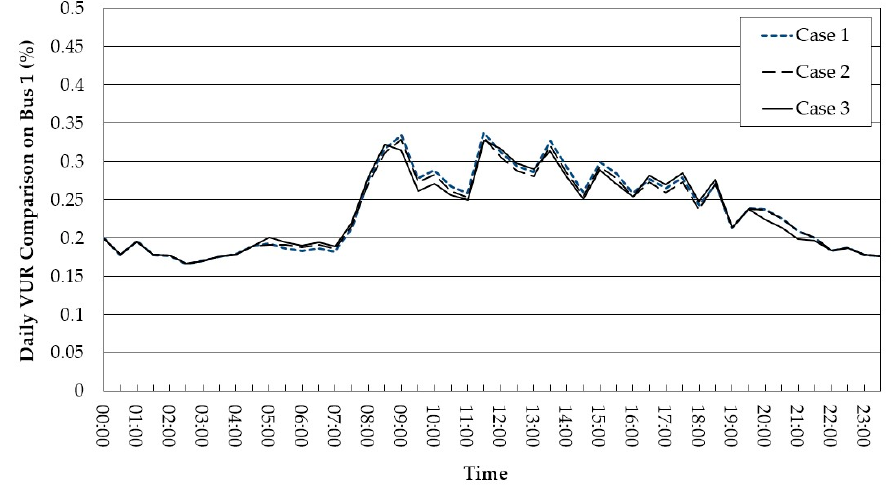
Figure 22. Daily VUR curve comparison on Bus 1.